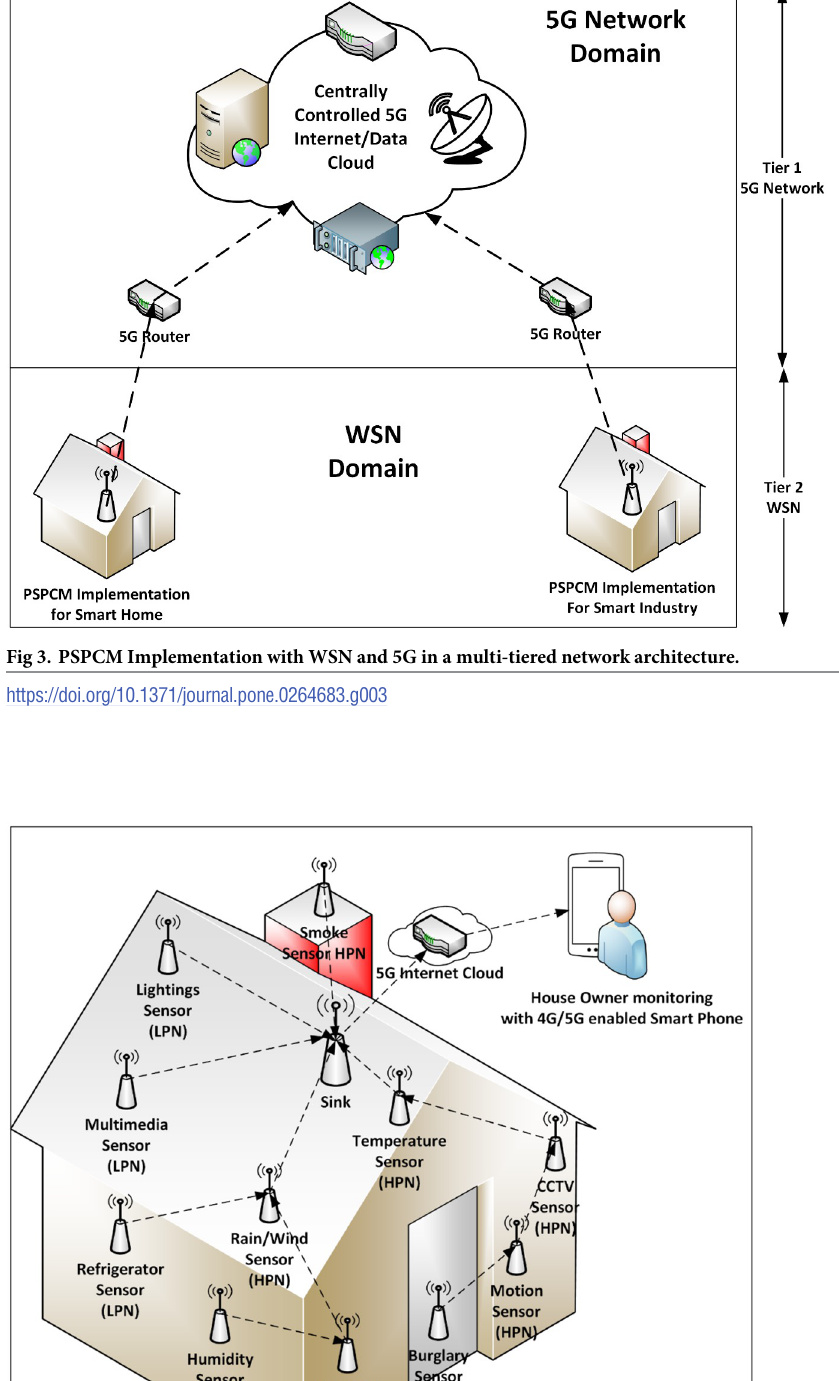
PLOS ONE | https://doi.org/10.1371/journal.pone.0264683 March 10,